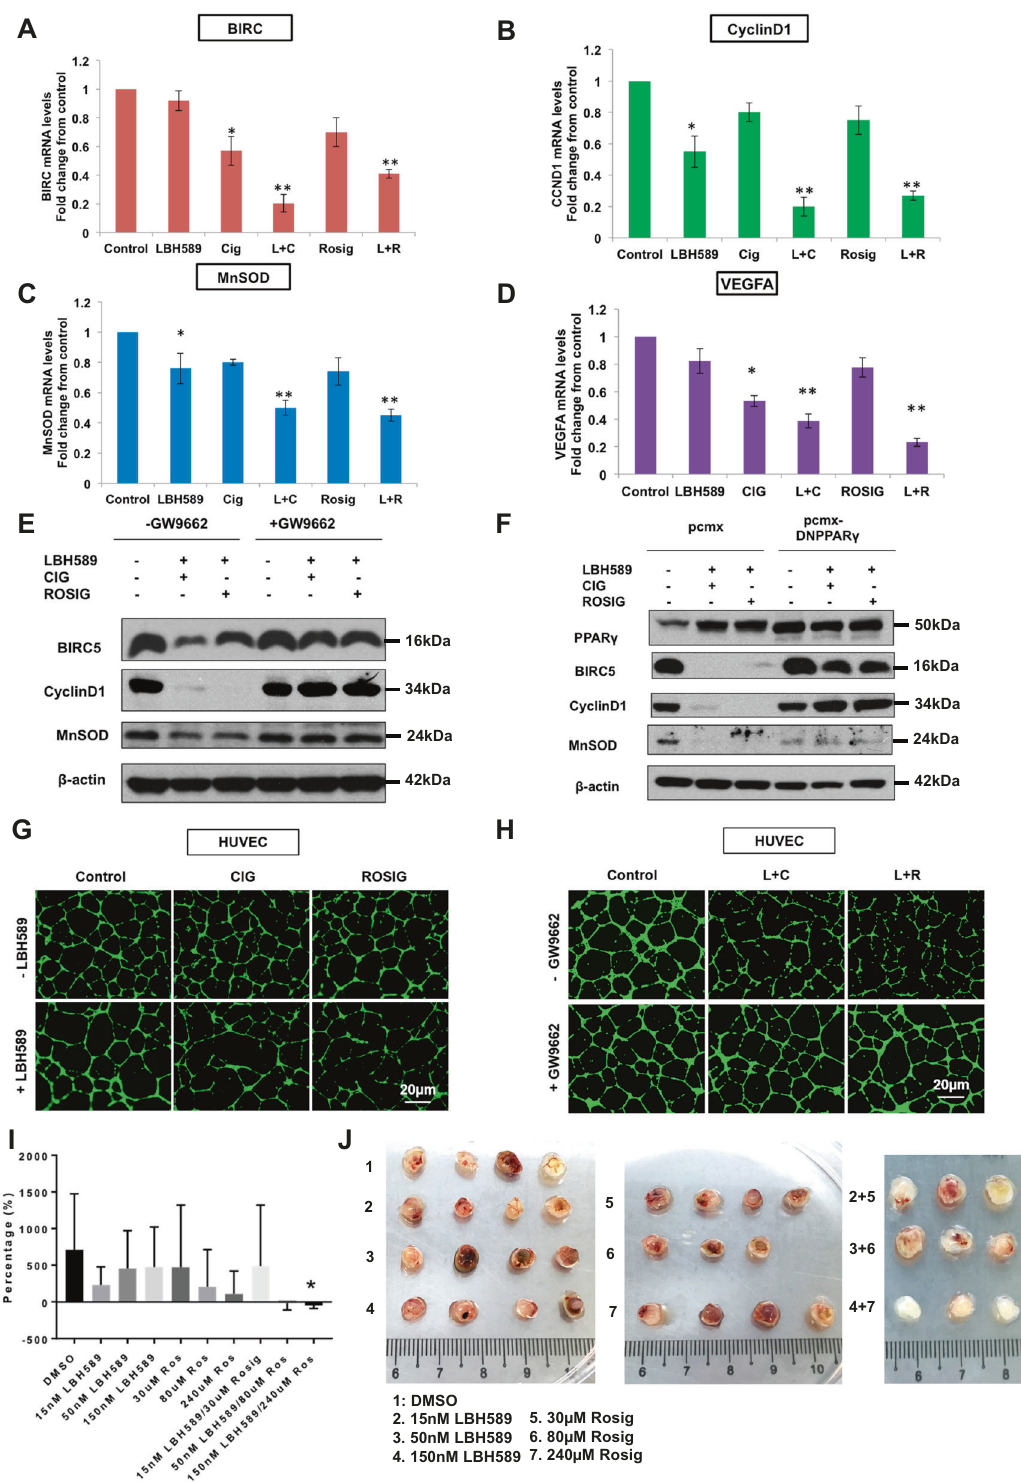
rosiglitazone (10 mg/kg or 20 mg/kg) or control (10% DMSO vehicle) for fi ve days per week of a three-week cycle. All treatment regimens were found to be well-tolerated, as none of the mice shed >10% of original bodyweight, and mice in all arms less those in the high-dose LBH589 group in fact gained bodyweight (Fig. 6A). Mice treated with 7.5 mg/kg LBH589 experienced less weight